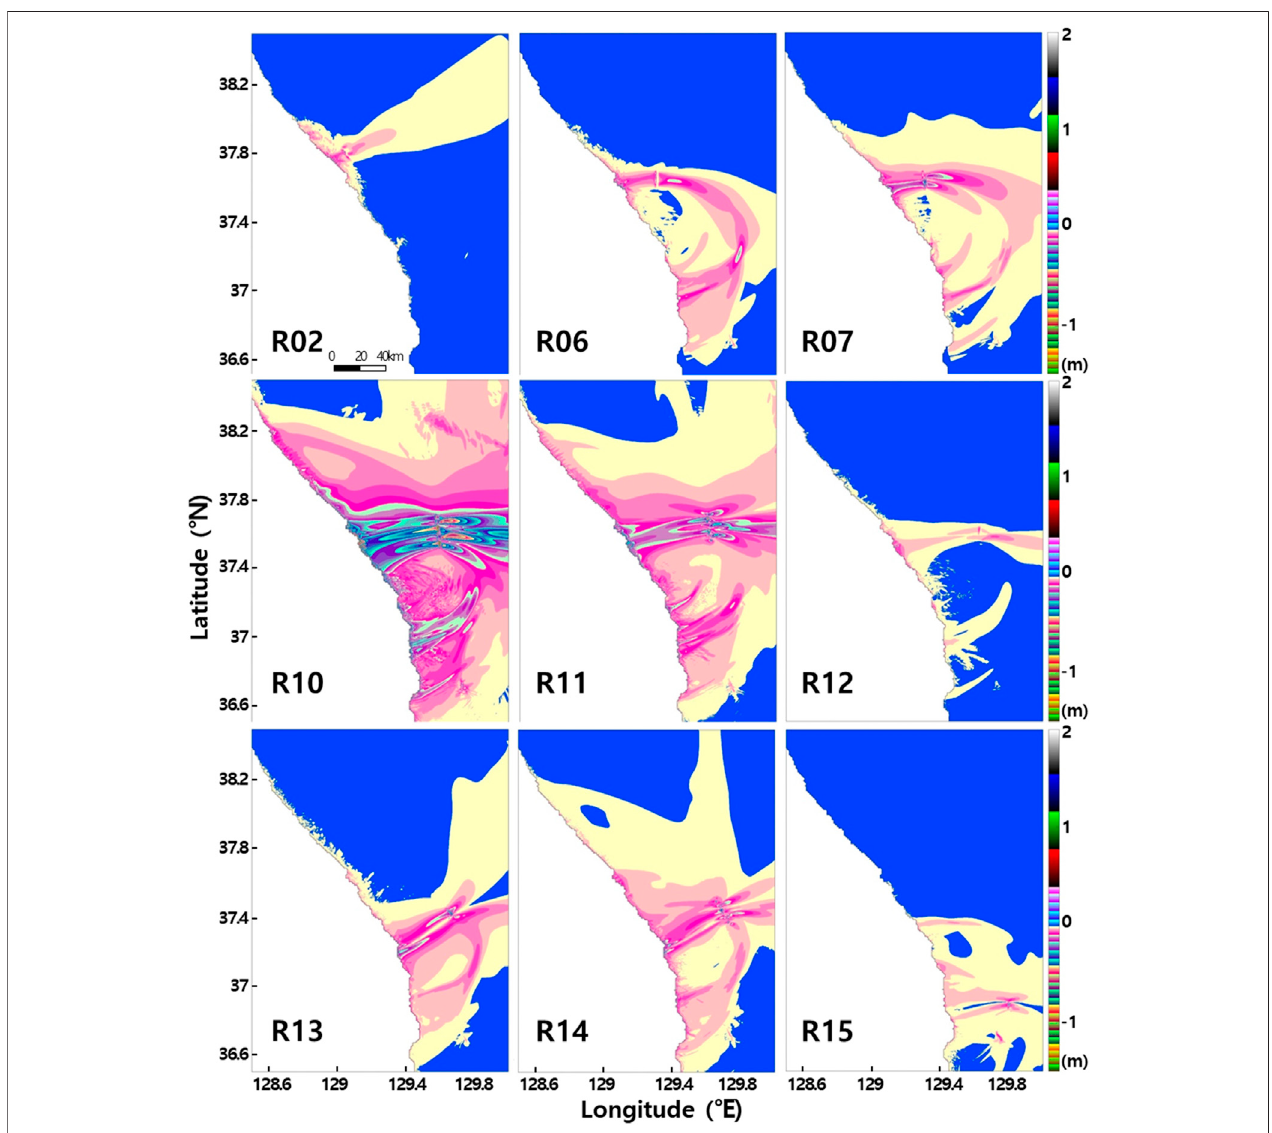
FIGURE 8 | Lowest elevation of tsunamis in the East Sea, estimated from numerical modeling for different scenarios (fault zones; Combination A).